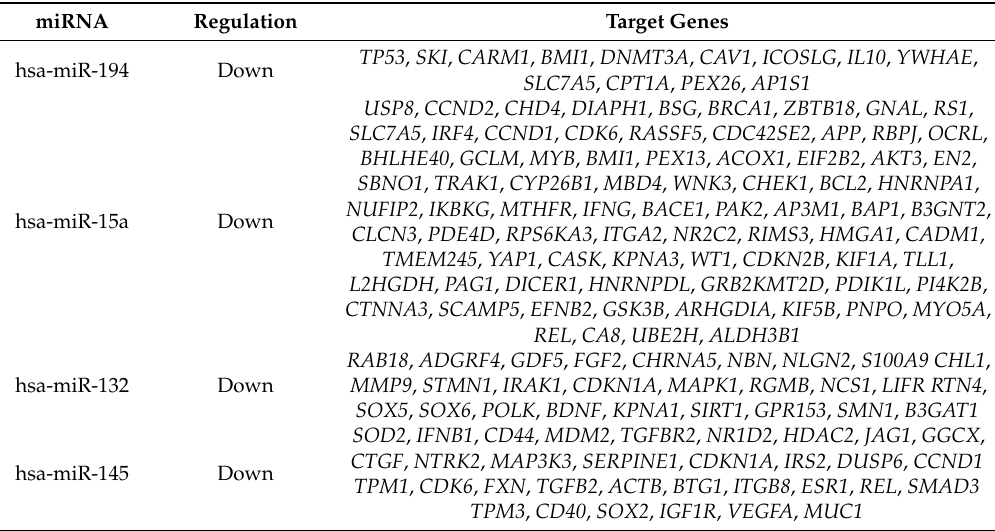
Table 3. Four target microRNAs regulating multiple